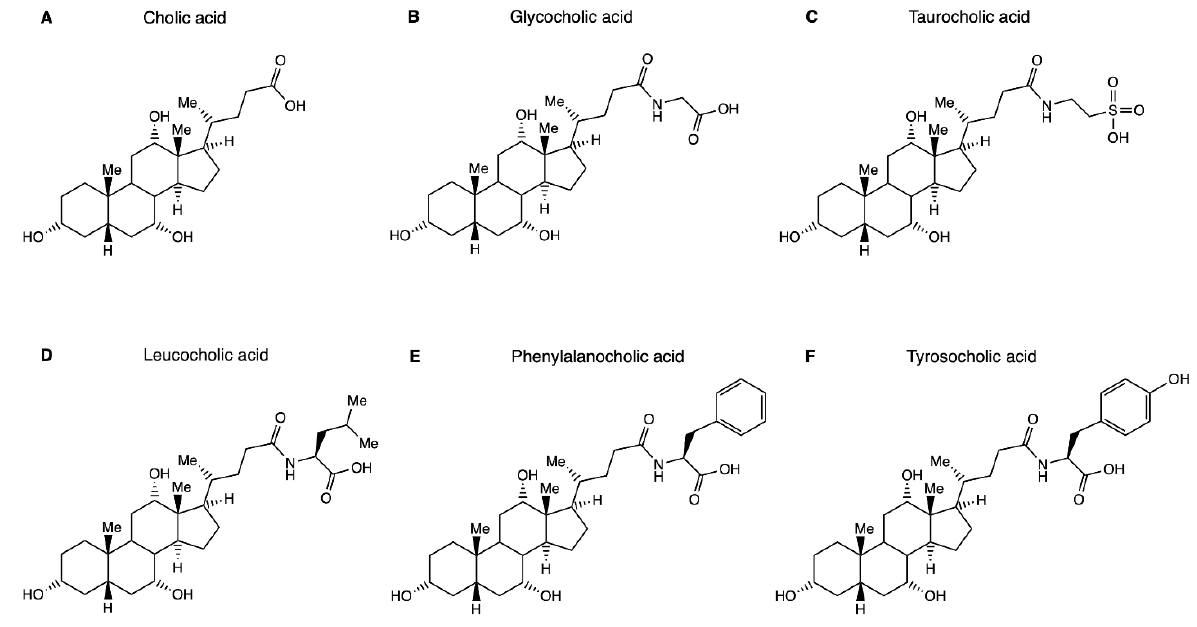
Figure 1. Structure of bile acids and host- and microbially conjugated variants. ( A ) Structure of the primary bile acid cholic acid that undergoes hepatic N -amidation with glycine or taurine to form glycocholic acid ( B ) or taurocholic acid ( C ). Specific gut microbial strains are capable of conjugating bile acids with a range of additional amino acids. Shown here are the three microbial bile salt conjugates that were discovered first, namely leucocholic acid ( D ), phenylalanocholic acid ( E ) and tyrosocholic acid ( F ). It is conceivable that the physicochemical properties of the amino acid employed for conjugation affect physicochemical and biological properties of the resultant bile salt conjugate.